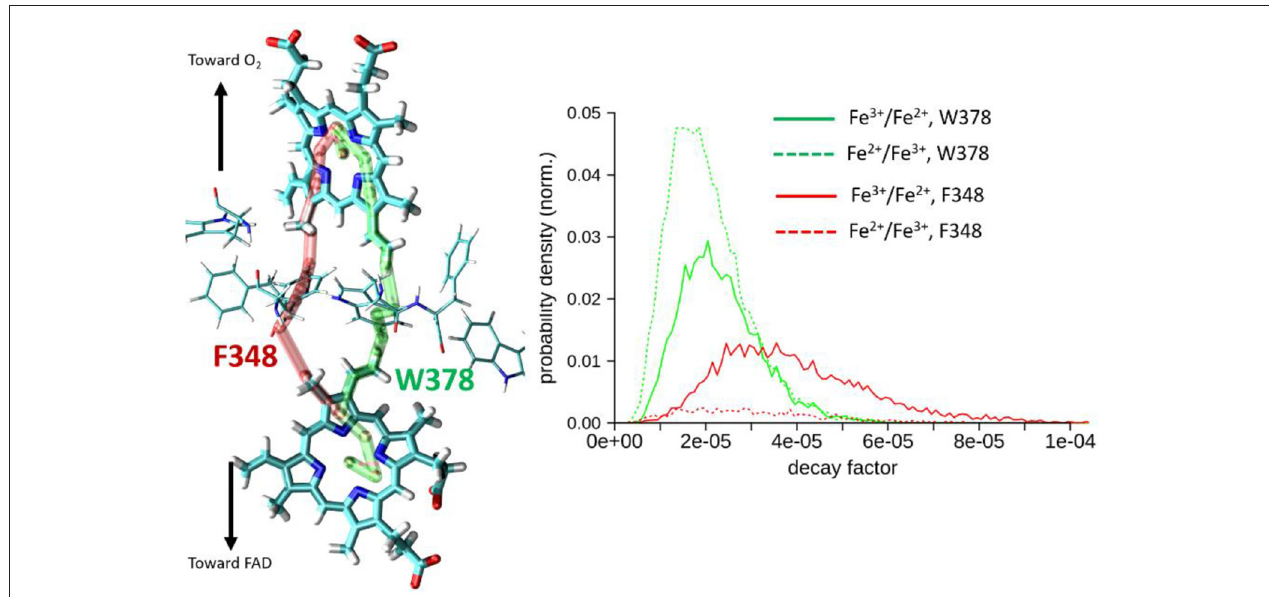
FIGURE 6 | Left, illustration of the two types of pathways encountered for heme-to-heme ET in NOX5 running either through Trp378 (in green) or through Phe348 (in red). Right, distributions of tunneling decay factors for MD simulations in the Fe 2 + /Fe 3 + and Fe 3 + /Fe 2 + redox states (in dashed and plane lines respectively), deconvoluted by pathway